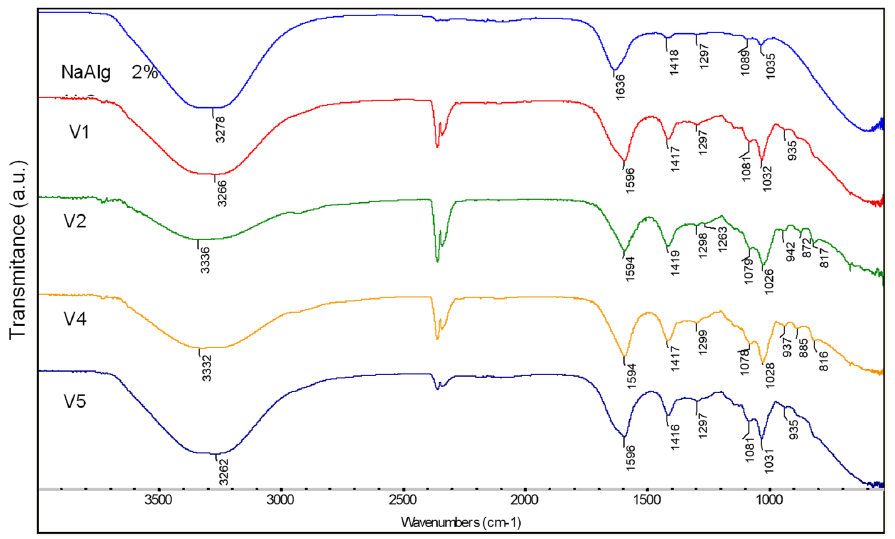
Figure 2. The FT ‐ IR spectra of NaAlg 2%, V1, V2, V4, and V5 hydrogels crosslinked with calcium chloride.